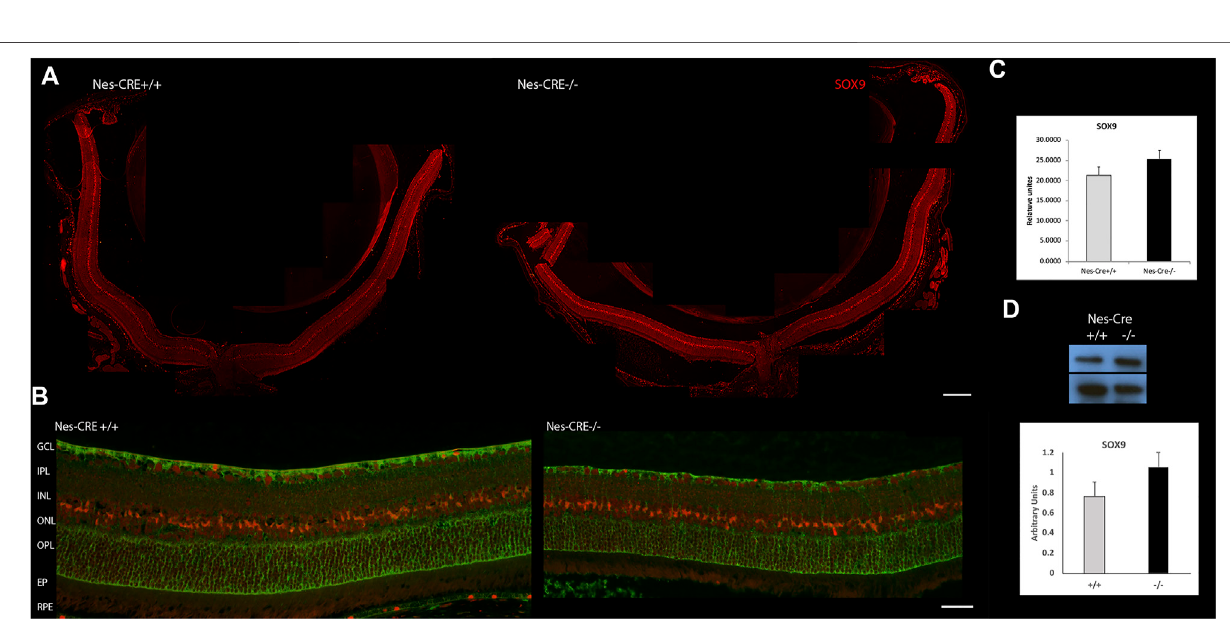
Frontiers in Genetics |